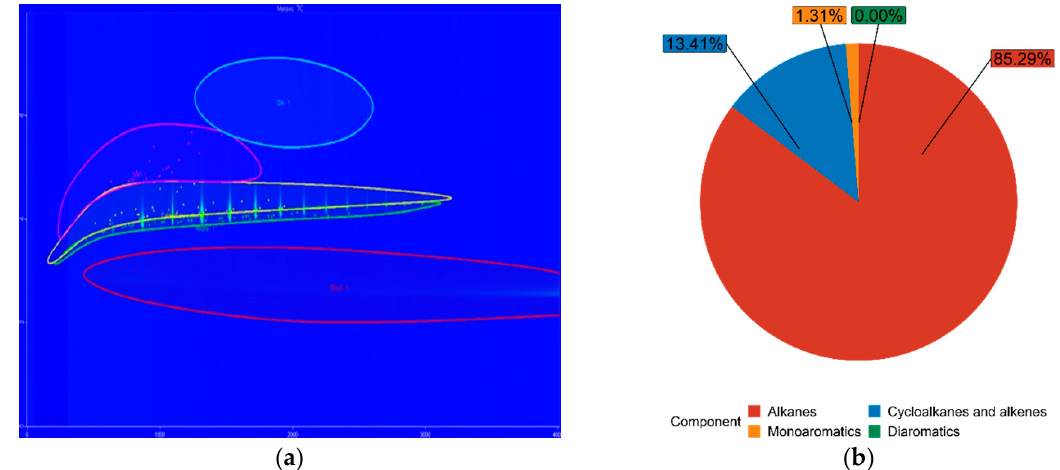
Figure 16. ( a ) Output of GC × GC-TOFMS for 70% FT − diesel; ( b ) hydrocarbon composition of 70% FT − diesel.